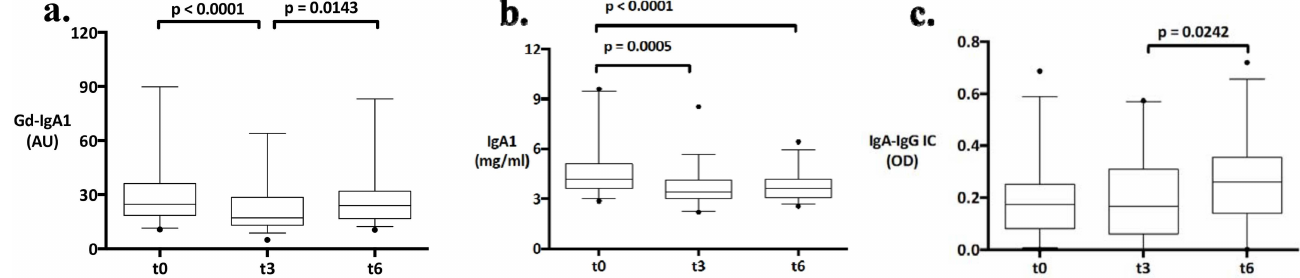
Fig 1. a, b, and c. Changes of galactose-deficient IgA1, total IgA1 and IgA-IgG complexes over time under influence of changing degrees of immunosuppression with tacrolimus, mycophenolate mofetil (MMF) and prednisone. Boxes represent the median50% of patients, lower and upper box ends are the 25th and 75th percentiles, and the middlebar represents the median. Whiskers link the lower/ upper box ends with the 5th and the 95th percentile. Outliers are representedby a closed